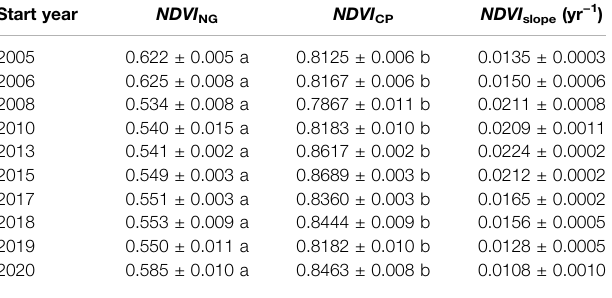
TABLE 2 | Changes in the normalized difference vegetation index ( NDVI ) between natural grassland (NG) and cultivated pasture (CP). NDVI values (mean ± SE) are labeled with different letters for signi fi cance ( t -test, p < 0.01). The NDVI slope represents NDVI trend from 2000 to